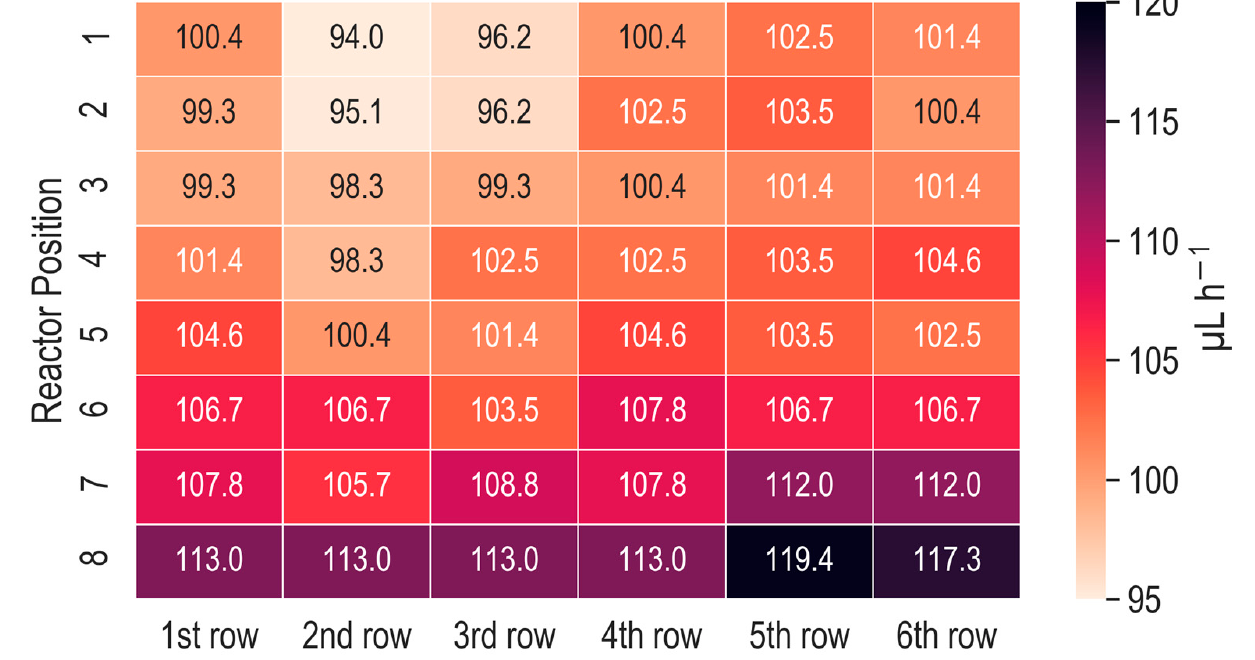
Figure 6. Evaporation rates during automated photoautotrophic batch cultivations of M. salina in stirred-tank PBRs. The layout represents the positioning of the 48 parallel PBRs inside the bioreactor. The final evaporation rates were estimated by totaling the quantities of individual sterile water added for automated liquid level correction. The inlet of the gas supply cover of the bioreaction unit is located between the 3rd and 4th rows of Reactor Position 8 (Figure 4c).